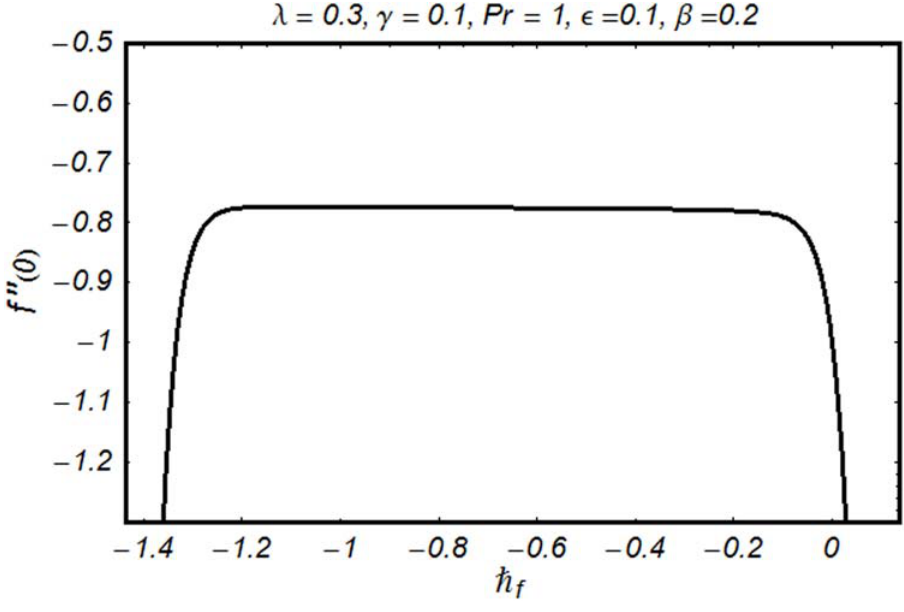
Fig 2. ℏ -curve for f